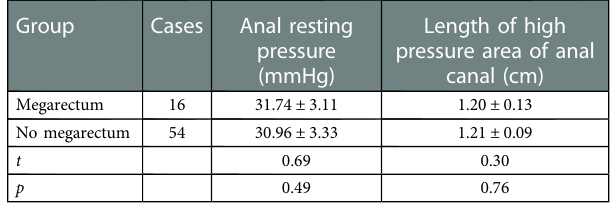
TABLE 4 Comparison of anorectal manometry between the two groups after operation.